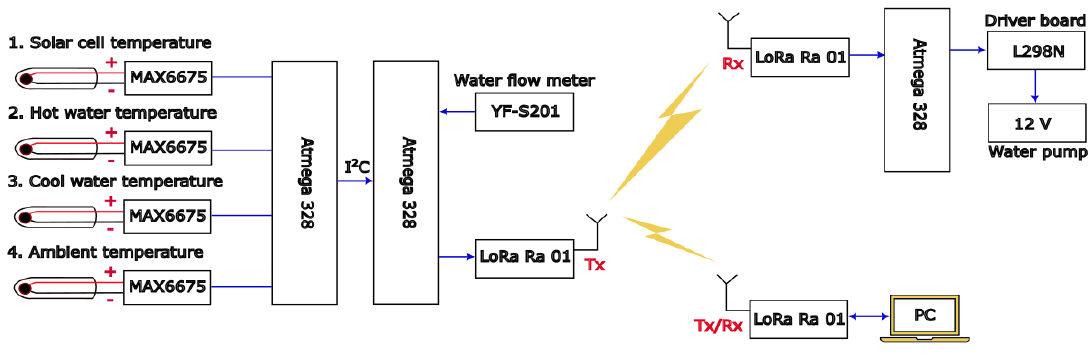
Figure 11. Silicon LCPV cooling system.